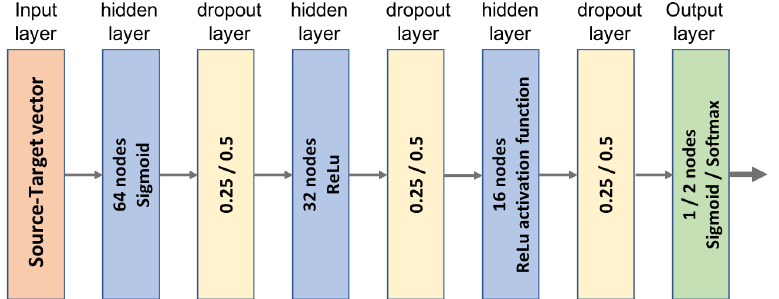
Figure 10. MLP architecture for classification tasks. For each layer, we report number of nodes, activation function and dropout value. When values are different for binary and multi-class tasks, we report them both, separated by a slash